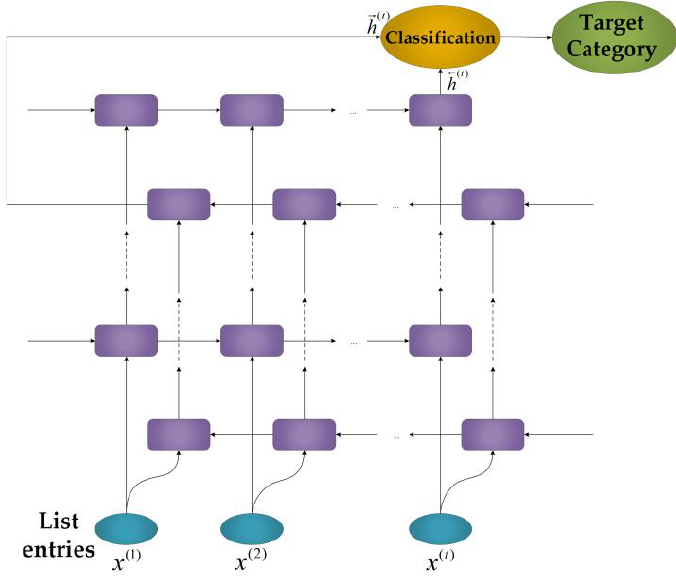
Figure 2. The StackedBiLSTM structure .